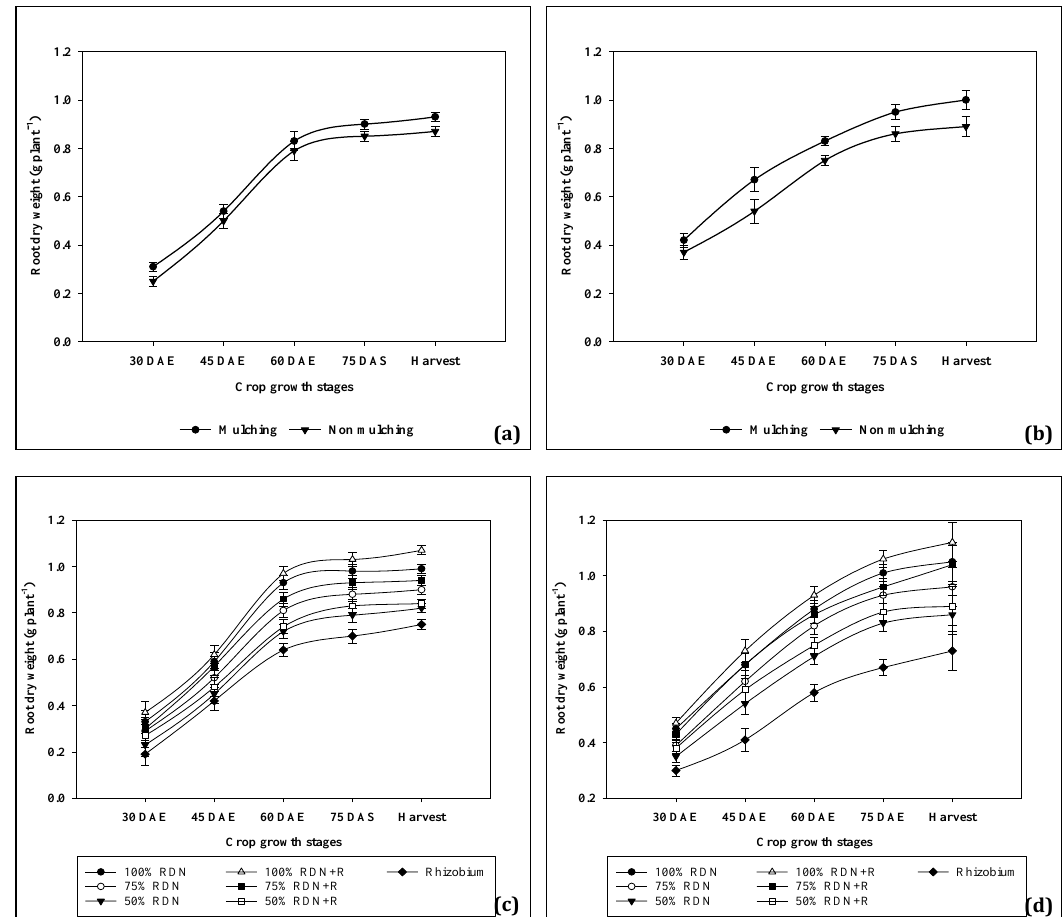
Figure 4. Effect of soil mulch ( a , b ) and nutrient management ( c , d ) on peanut root dry weight at different growth stages (data from 2015–2016 and 2016–2017 crop seasons, respectively). DAE—days after emergence; error bars represent the least significant difference values.